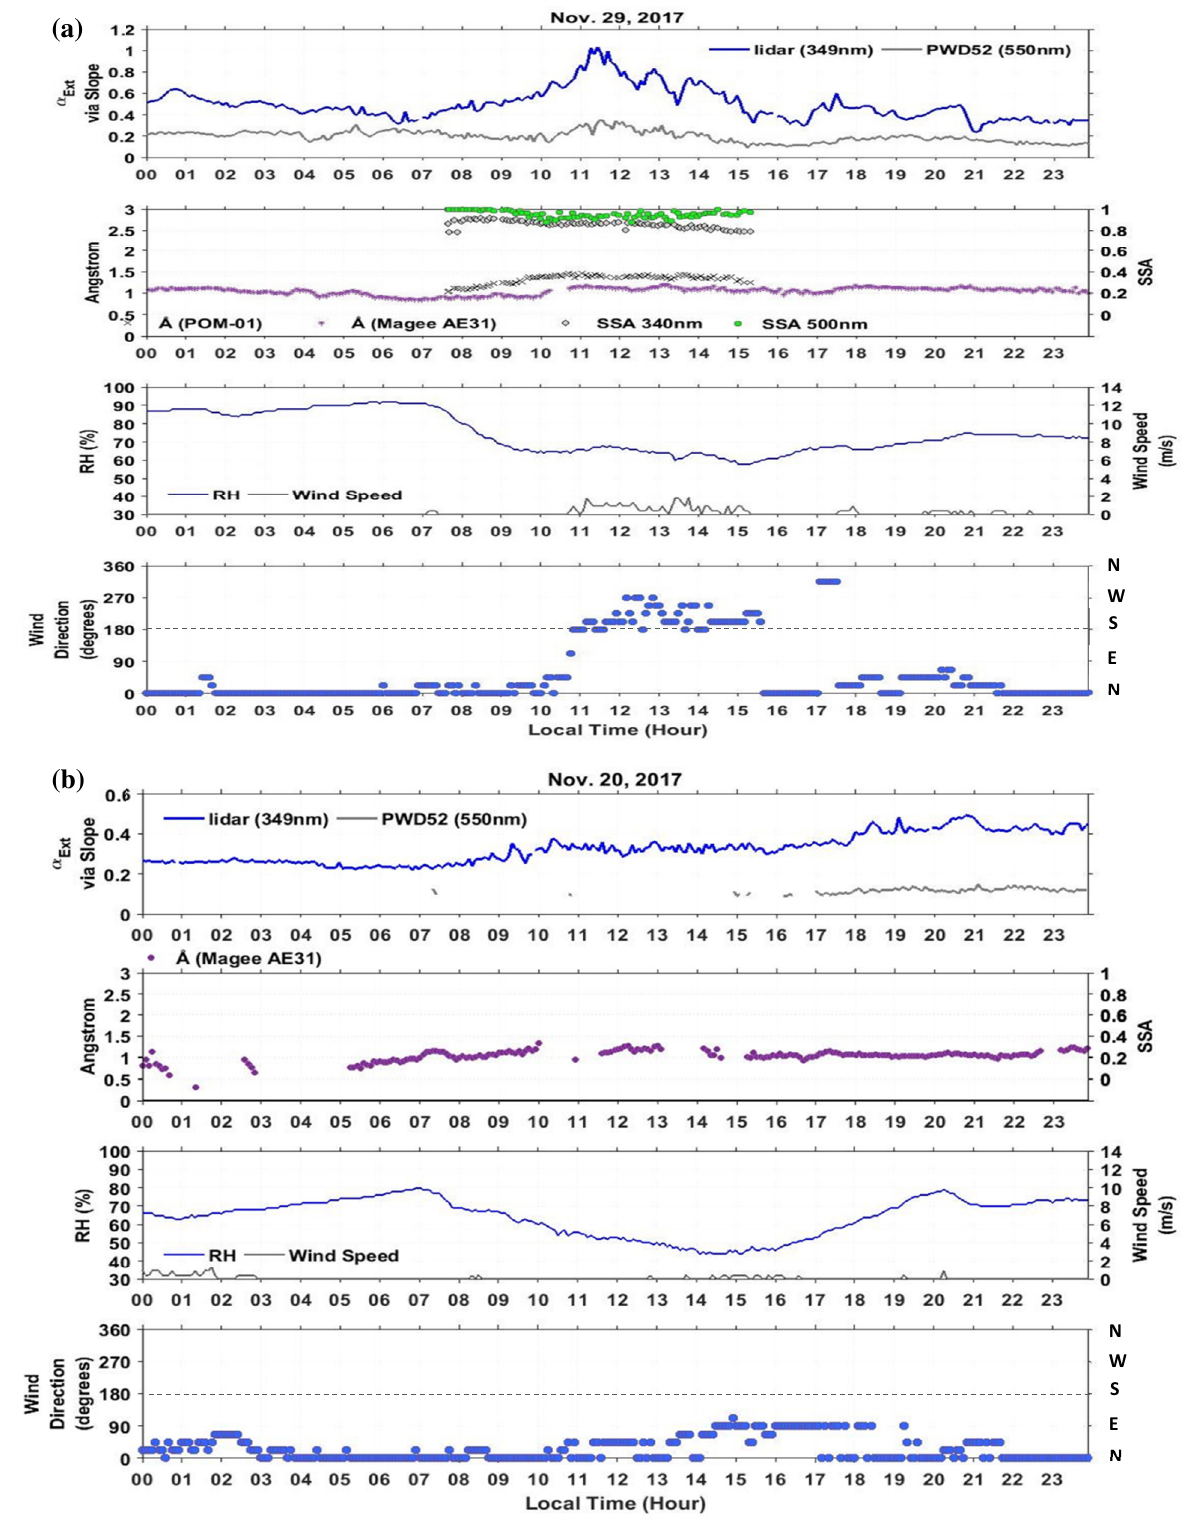
Fig. 2. Example of the diurnal cycle of aerosol optical properties in (a) clear with low visibility sky condition on November 29, and (b) cloudy sky condition on November